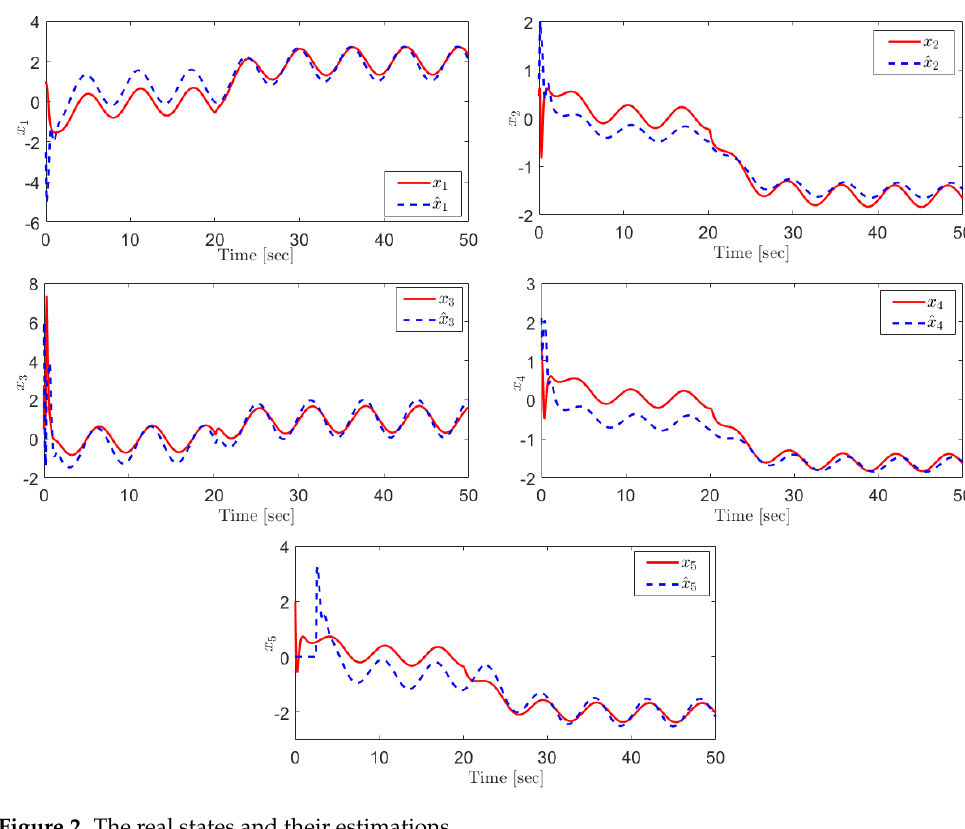
Figure 2. The real states and their estimations.